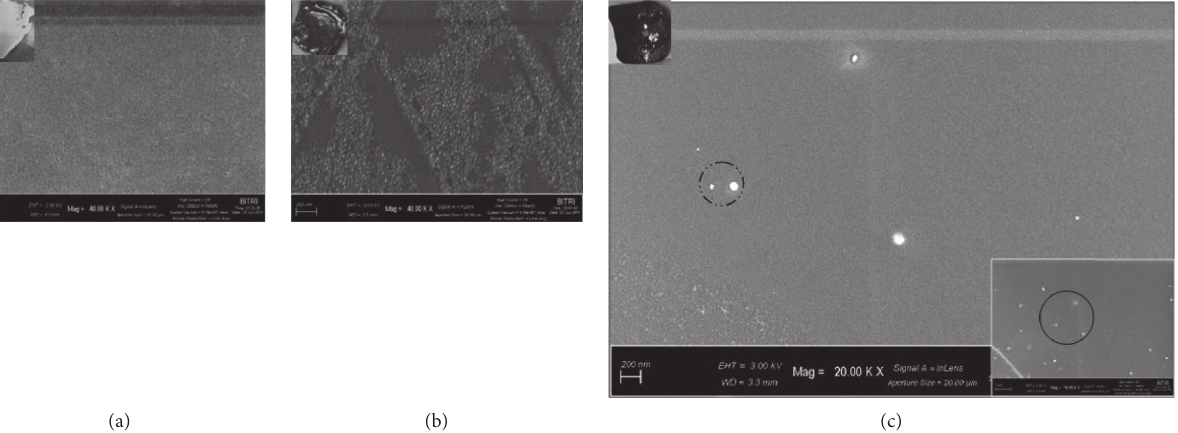
Figure 7: Scanning Electron Microscopy (SEM) images of thermally cured phase inverted PAA films: The insets are the recorded pictures of PAA films. (a) SEM image of the PAA film at magnifications of 40000x. (b) SEM image of the Ag-PAA film at magnifications of 40000x. Surface of the Ag-PAA film is with well-dispersed silver nanoparticles showing spherical shapes. (c) SEM image of the Au/Ag-PAA film at magnifications of 20000x. Surface of the Au/Ag-PAA film is with different nanoparticles. The circled part shows gold and silver nano- particles in close